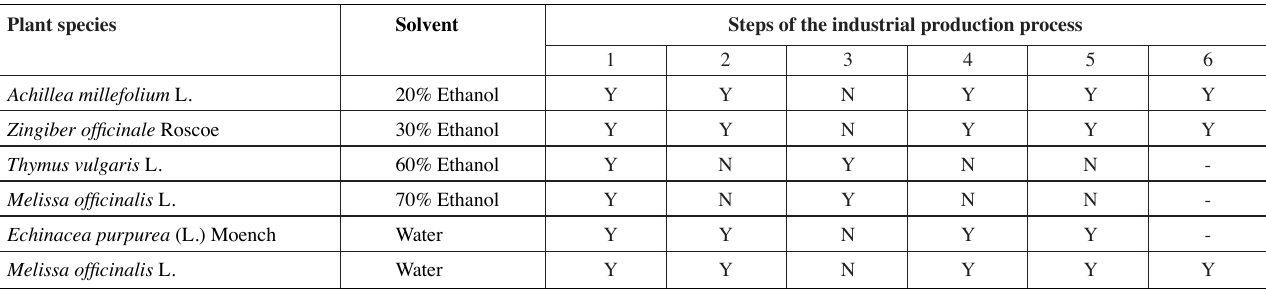
Tab. 2: List of six commercial MAPs (phytoextracts) traced along their entire production chain. Each sample (intermediates of industrial production) was treated for DNA extraction and DNA barcoding analysis using the minibarcode region rbcL 1-B. Numbers indicate the industrial processing step as described in Fig. 1. Y= correct plant identification by DNA barcoding at rbcL 1-B locus, N= DNA extraction or amplification failure, - = Sample was not collected and